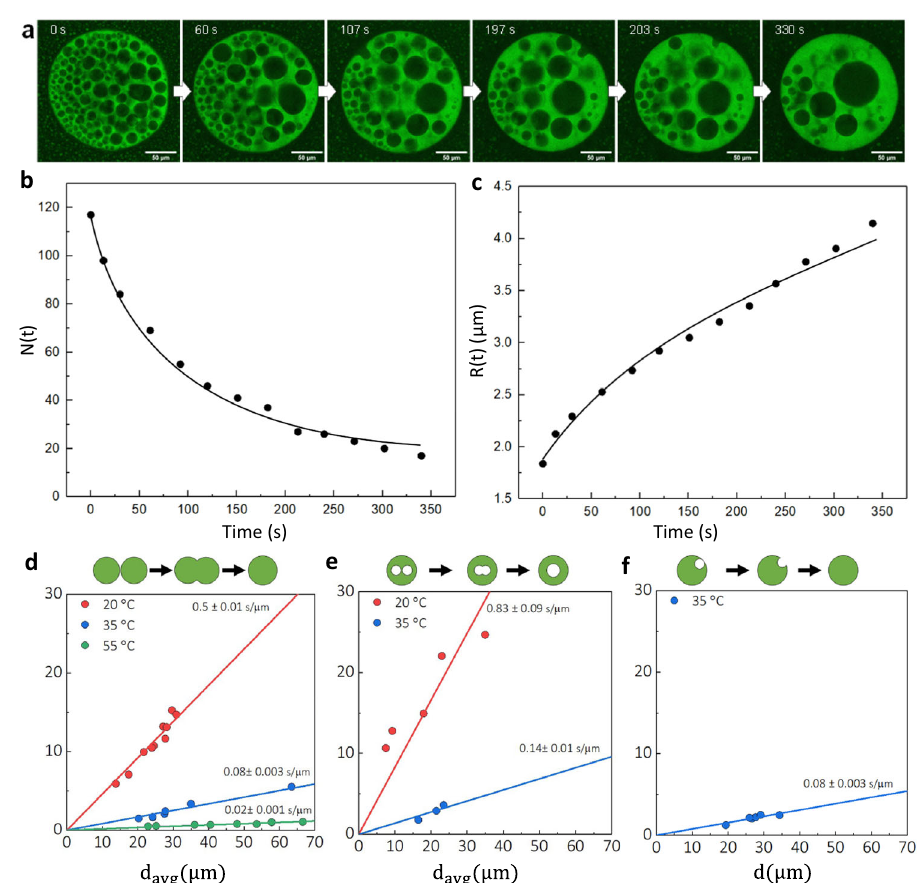
thefusingof d condensates, e trappeddropletsand f dropletswiththeouterdilute phase, weextractthe characteristic merging time τ . The slopeofthe plot τ against the average diameter of merging droplets isthe inverse capillary velocity, which is approximately equal to the viscosity over the surface tension 6,27 .